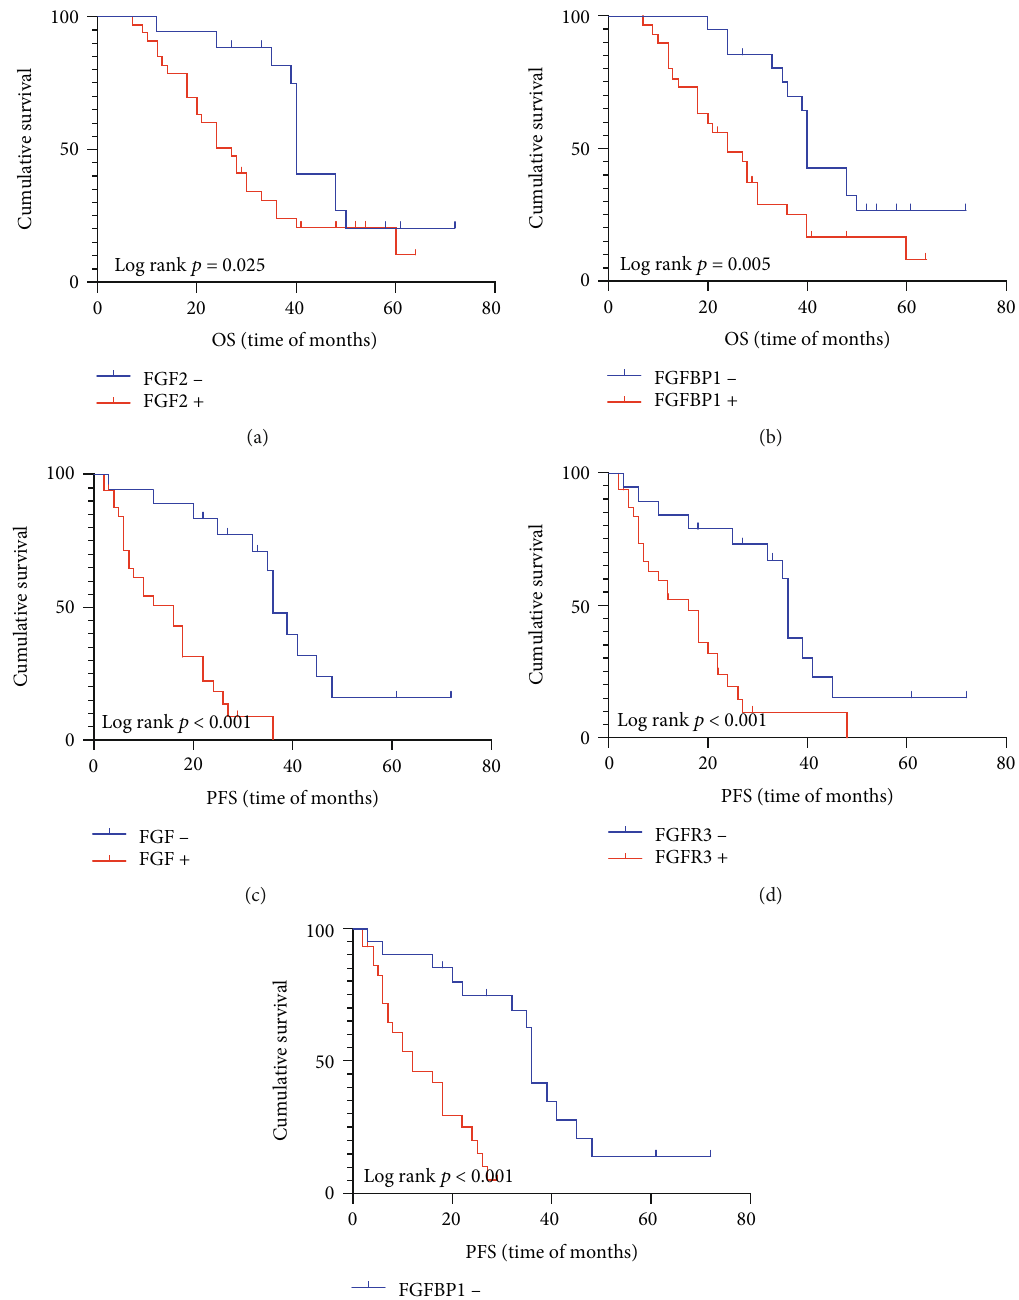
Figure 6: Kaplan – Meier survival analysis: total and progression-free survival in patients undergoing postoperative chemotherapy. (a) The OS of patients with FGF2 overexpression was shorter in ESCC ( p = 0 : 025 ); (b) the high expression of FGFR3 had a poor OS in ESCC ( p = 0 : 05 ); (c) the high expression of FGFBP1 had a poor OS in ESCC ( p = 0 : 005 ); (c) the PFS of patients with FGF2 overexpression was shorter in ESCC ( p < 0 : 001 ); (e) the high expression of FGFR3 had a poor PFS in ESCC ( p < 0 : 001 ); (f) the high expression of FGFBP1 had a poor PFS in ESCC ( p < 0 : 001